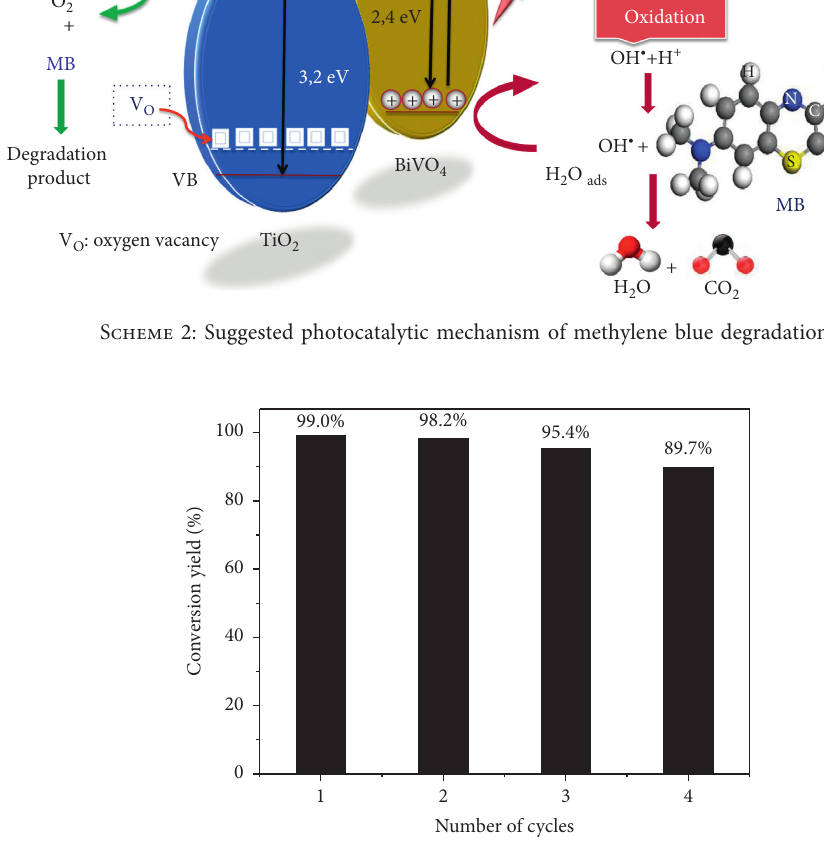
4 /TiO 2 photocatalyst.